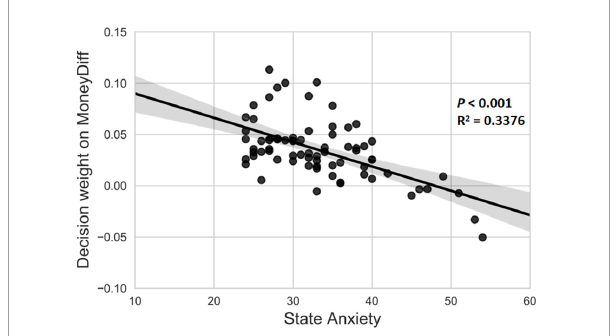
FIGURE5 Decision weight on MoneyDiff was significantly negatively correlated with state